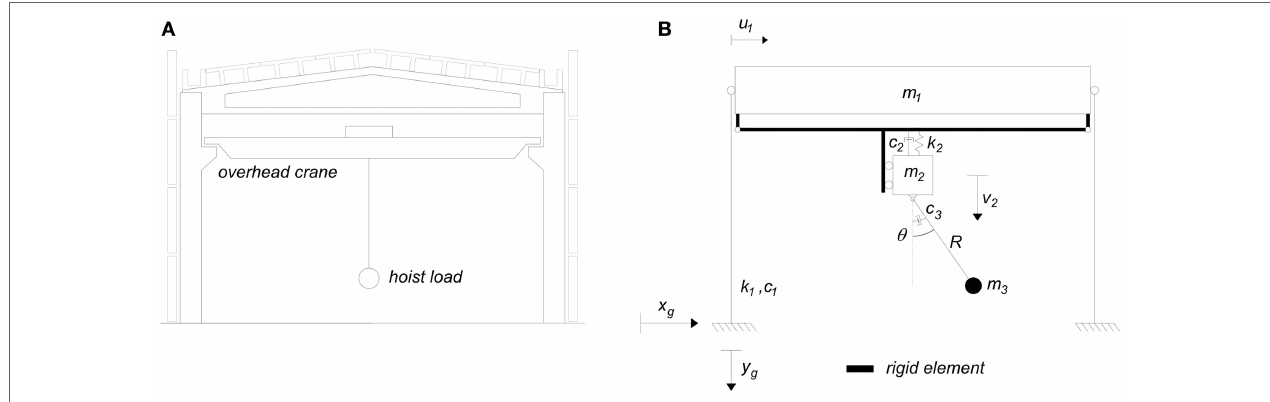
FigUre 2 | (a) Precast portal frame with overhead crane. (B) Considered simplified 3 degrees of freedom system (3DOF). m 1 is the roof mass; k 1 and c 1 are the lateral stiffness and viscous damping of the columns; m 2 is the mass of the overhead crane; k 2 and c 2 are the vertical stiffness and viscous damping of the crane; m 3 and c 3 are the mass and viscous damping of the hoist load, respectively; R is the length of the